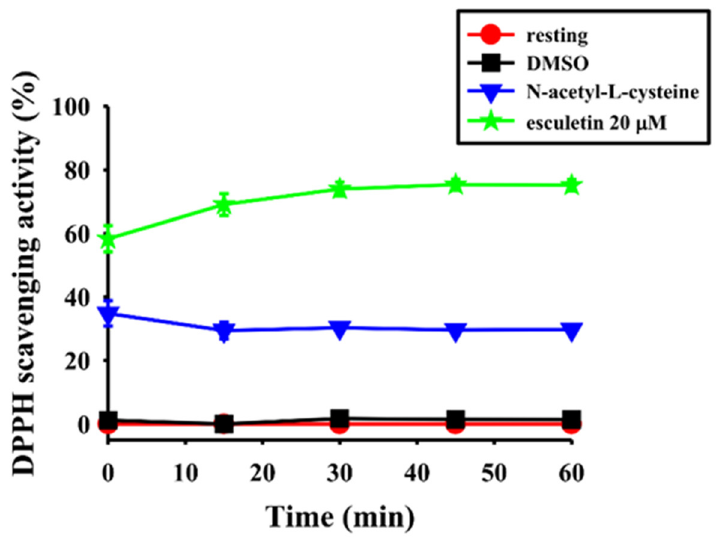
Figure 6. Esculetin scavenges 2,2-diphenyl-1-picrylhydrazyl (DPPH) radical formation in RAW cells. DPPH–methanol (300 µM) was mixed with esculetin (20 µM) and then incubated for 30 min. The absorbance at 517 nm was determined using a spectrophotometer.